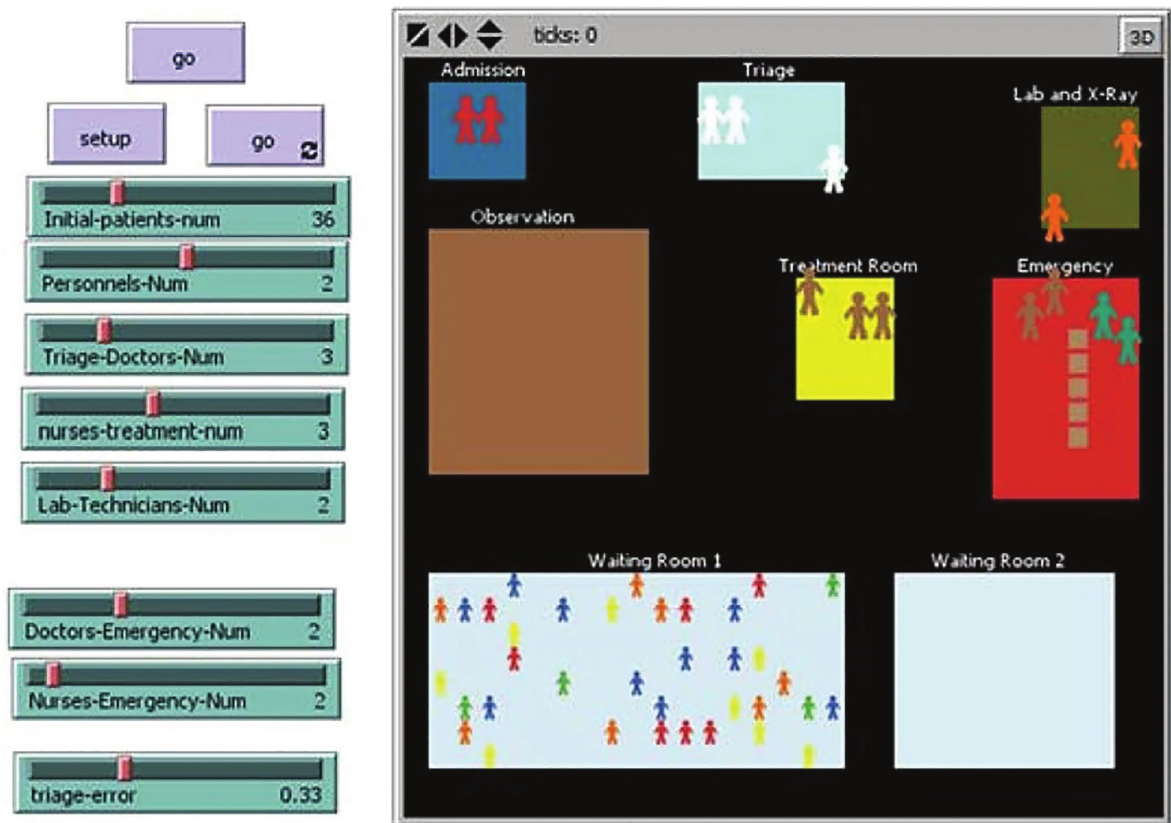
Figure 4. Graphical user interface and 2D visualization of the simulation in NetLogo software